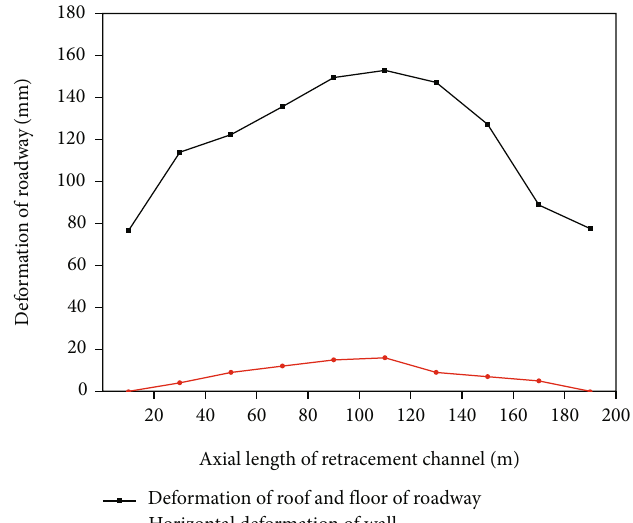
Figure 18: Deformation of retracement channel.